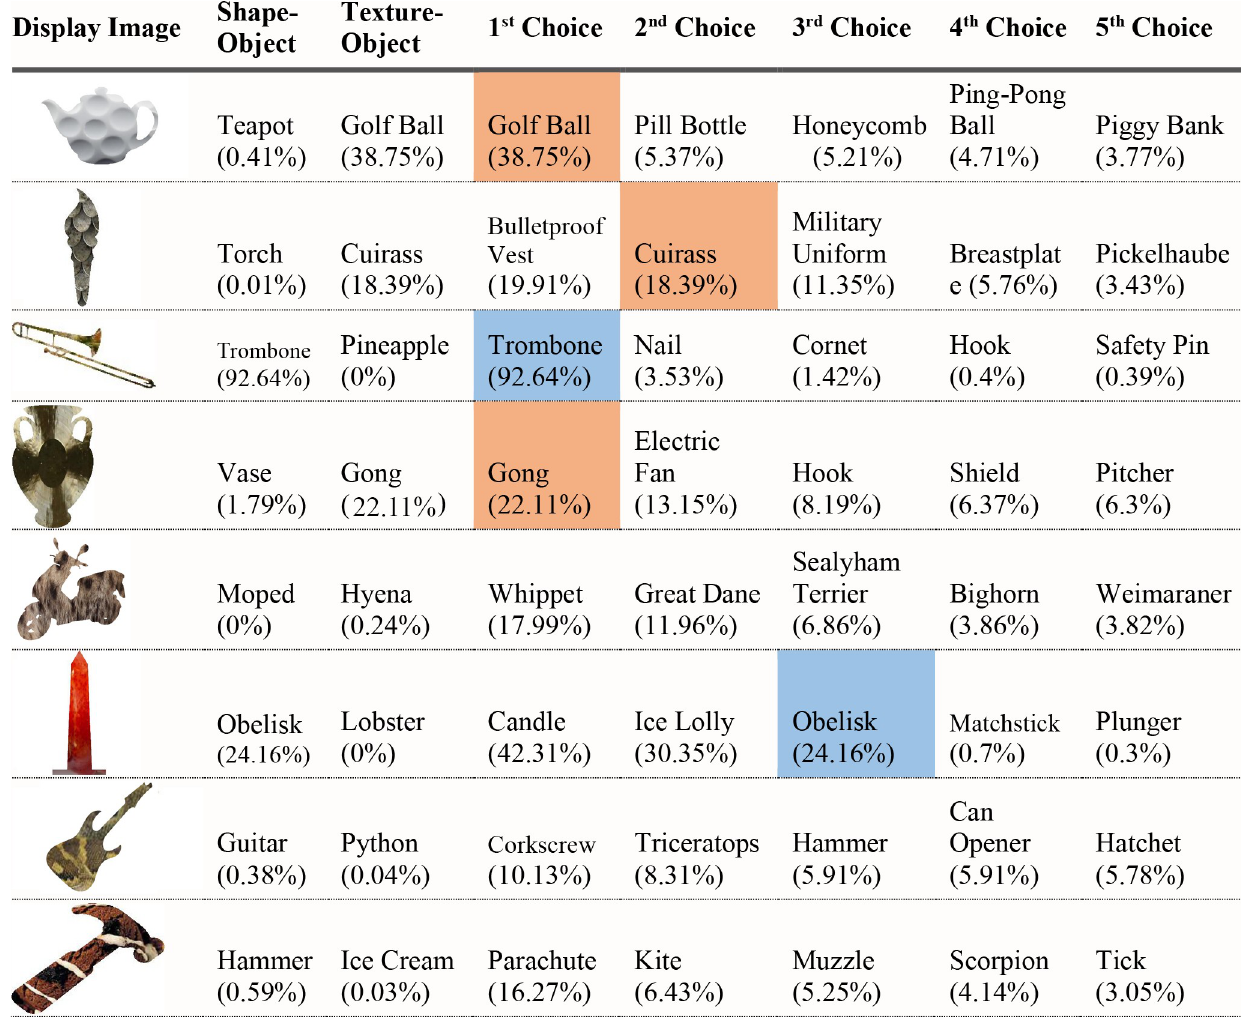
Fig 6. Network classifications for the stimuli presented in Experiment 1 Part